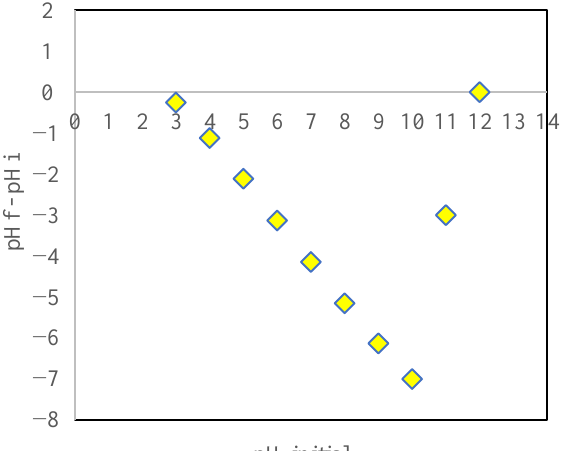
Figure 5. pHpzc of SMCB/Fe.